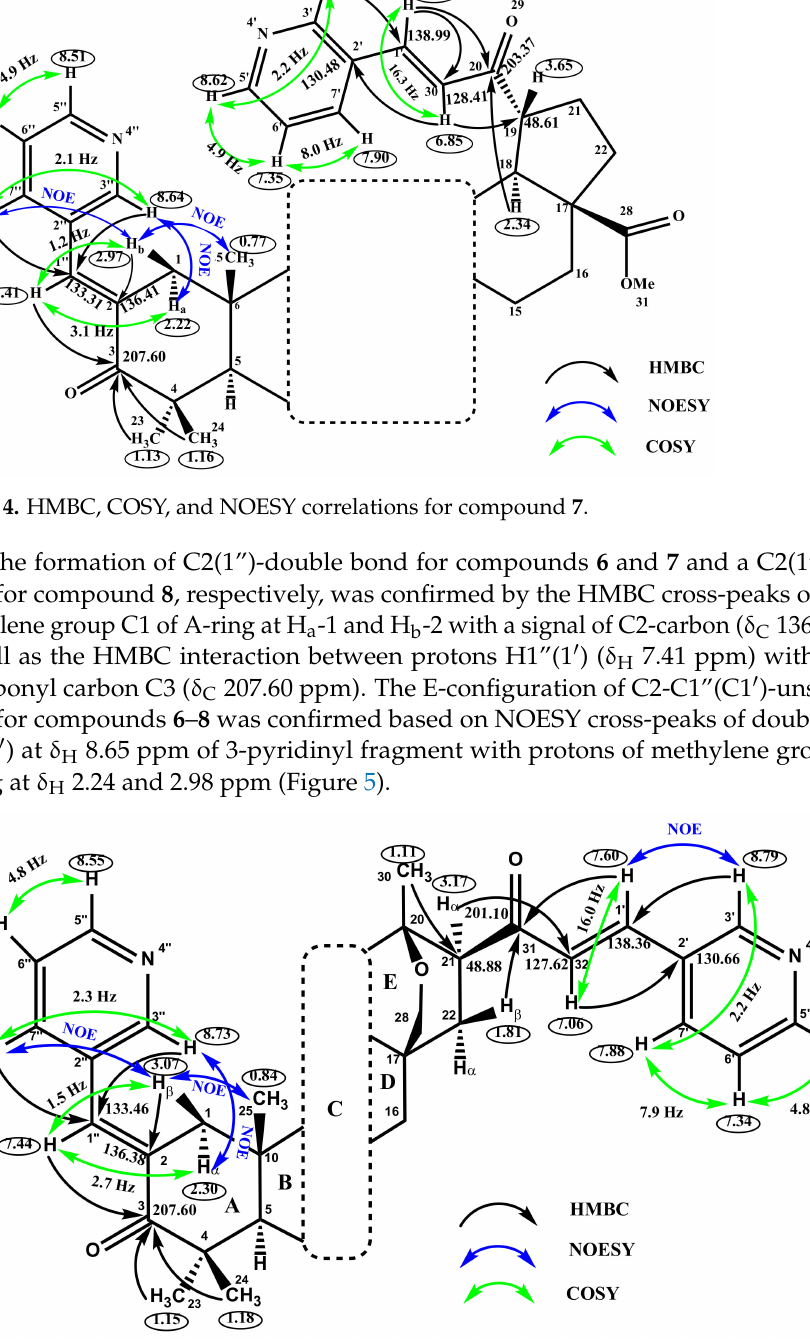
Figure 5. HMBC, COSY, and NOESY correlations for compound 6